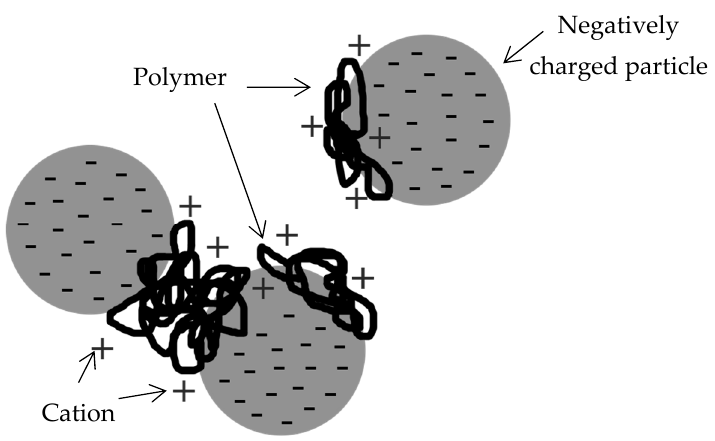
Figure 2. Mechanism of patching flocculation.